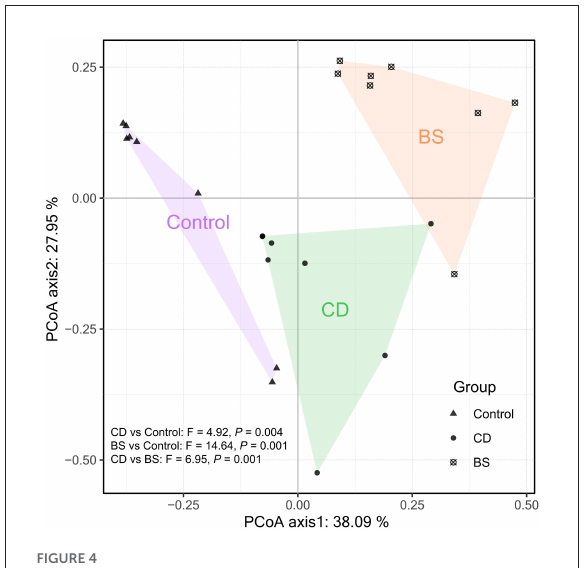
FIGURE4 Principal coordinates analysis (PCoA) plot based on Bray-Curtis dissimilarity visualizing dissimilarities in the intestinal bacterial